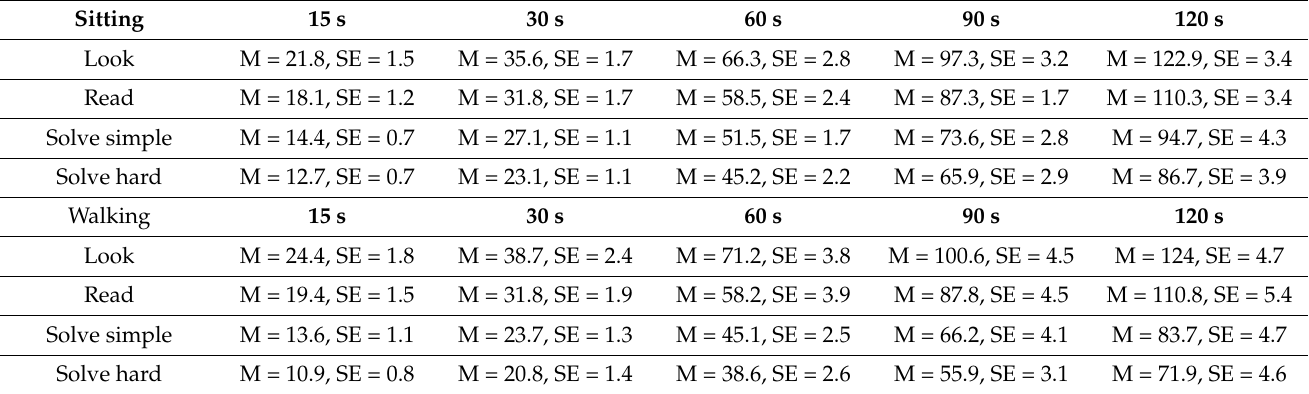
Table 1. Time estimation averaged over every participant for each task and time interval (with standard errors across participants), in the sitting and walking